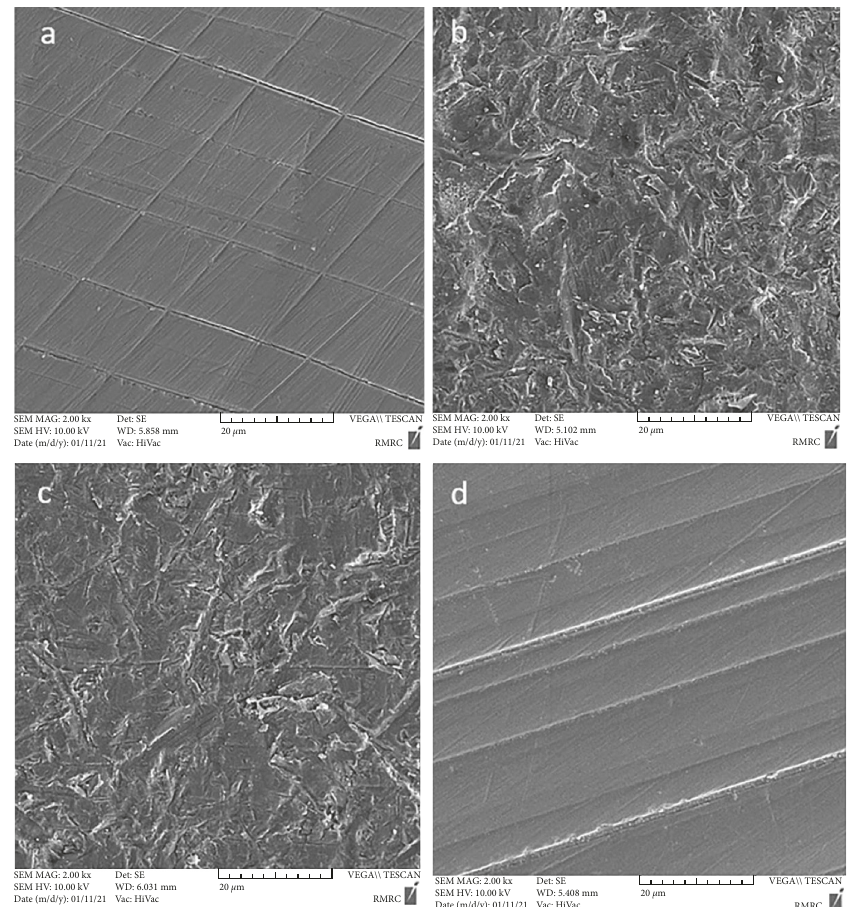
Figure 3: Scanning electron microscopic micrographs from the zirconia surface after different surface treatments at (a) Control; (b) airborne-particle abrasion; (c) CoJet; (d) CO 2